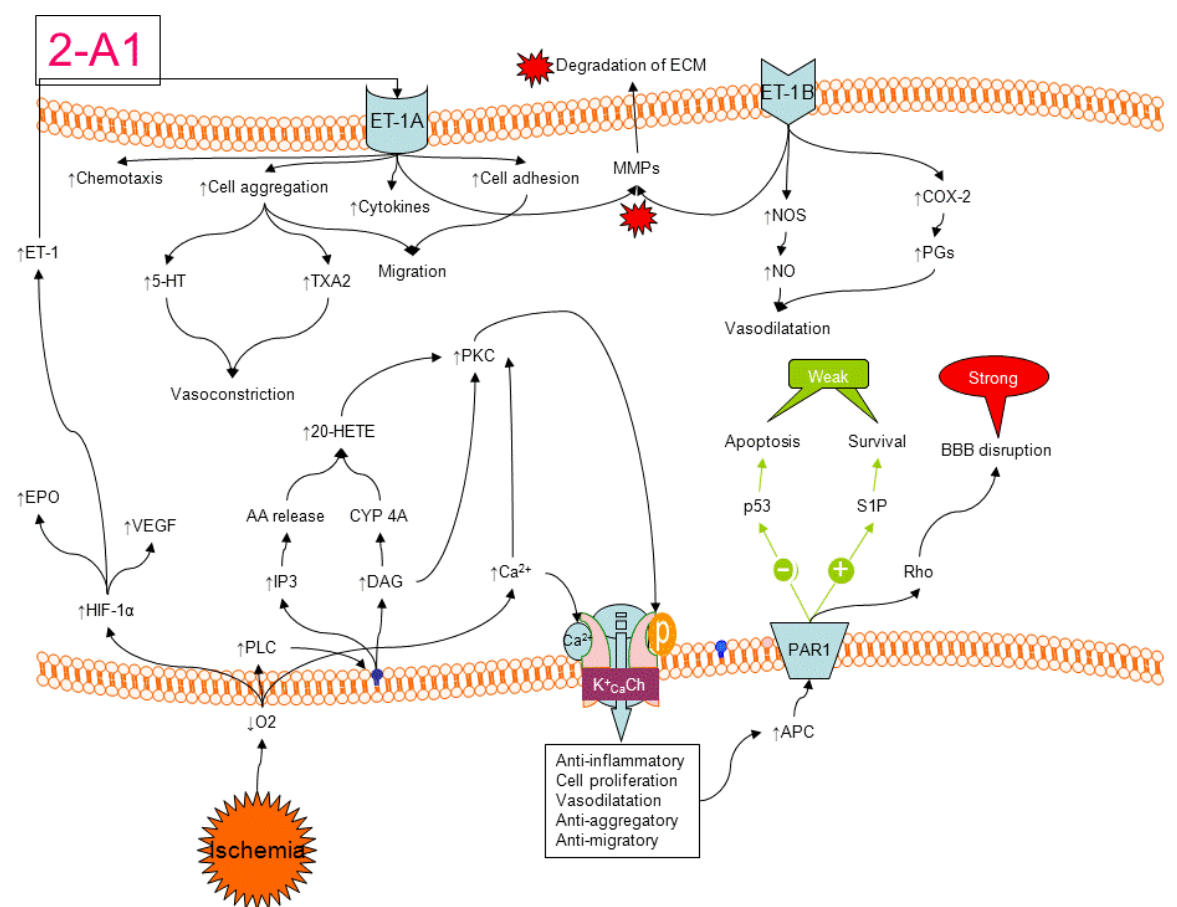
FIGURE 2-A1. Injuries caused by ischemia occur in a wide range of subcellular regions, including the capillary endothelium in nongenomic levels (green arrow: neuroprotective; red burst: neurodegenerative). Abbreviations not listed for previous figures: 5-HT, 5-hydroxytryptamine; AA, arachidonic acid; APC, activated protein C; CYP; cyclophilin; DAG, diacyl glycerol; EPO, erythropoietin; ET-1, endothelin-1 A and B; HETE, hydroxyeicosatetraenoic acid (lipoxygenase products); IP3, inositol triphosphate; K + channel; PAR1, protein-activated receptor 1; PG, prostaglandin; PKC, protein kinase C; PLC, phospholipase C; S1P, sphingosine 1-phosphate; TXA2, thromboxane